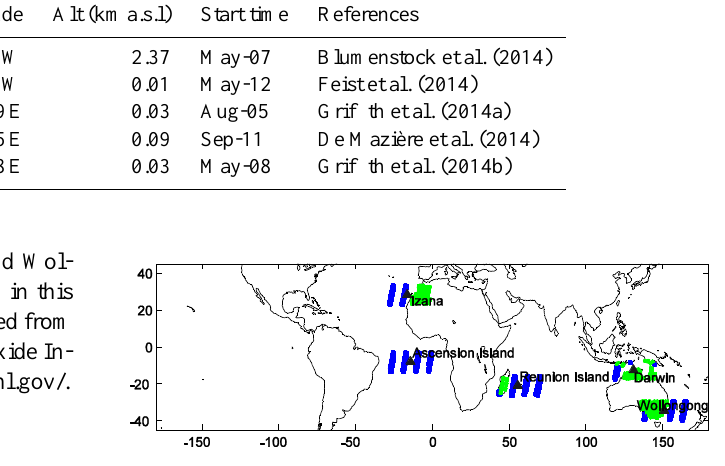
Figure 1. TCCON stations and SRPR XCH 4 co-located footprints from April 2009 to December 2013. The colocation box is chosen as ± 5 ◦ latitude ± 15 ◦ longitude around the TCCON station. The blue footprints are sun glint data over ocean, and the green ones are data above